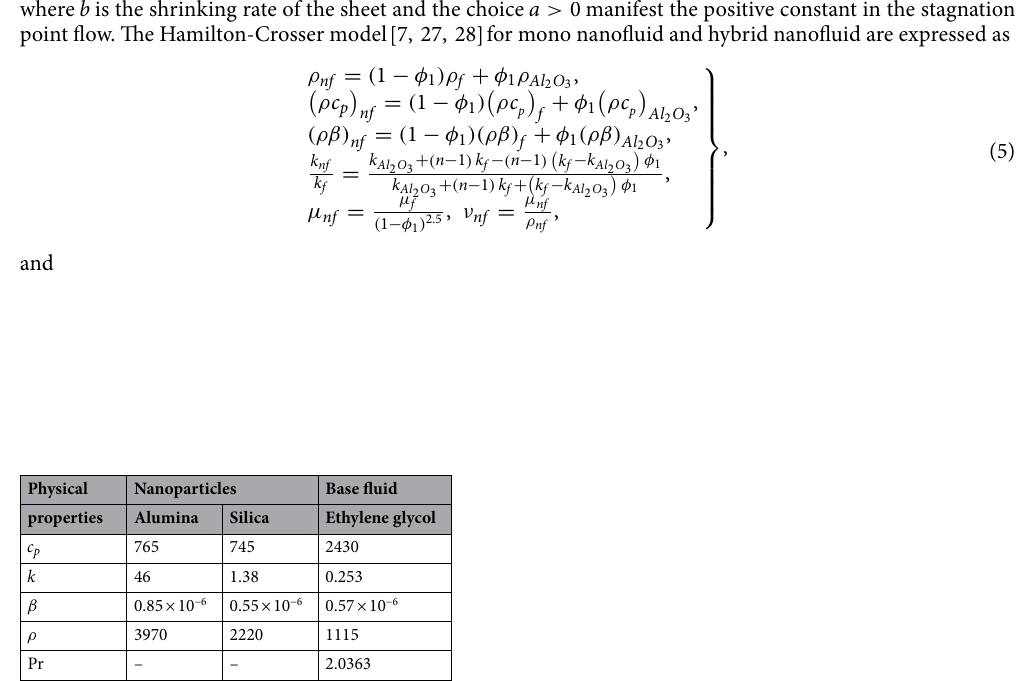
Table 1. Thermophysical properties of Al 2 O 3 , SiO 2 , and C 2 H 6 O 2 (see Refs. [29, 30]